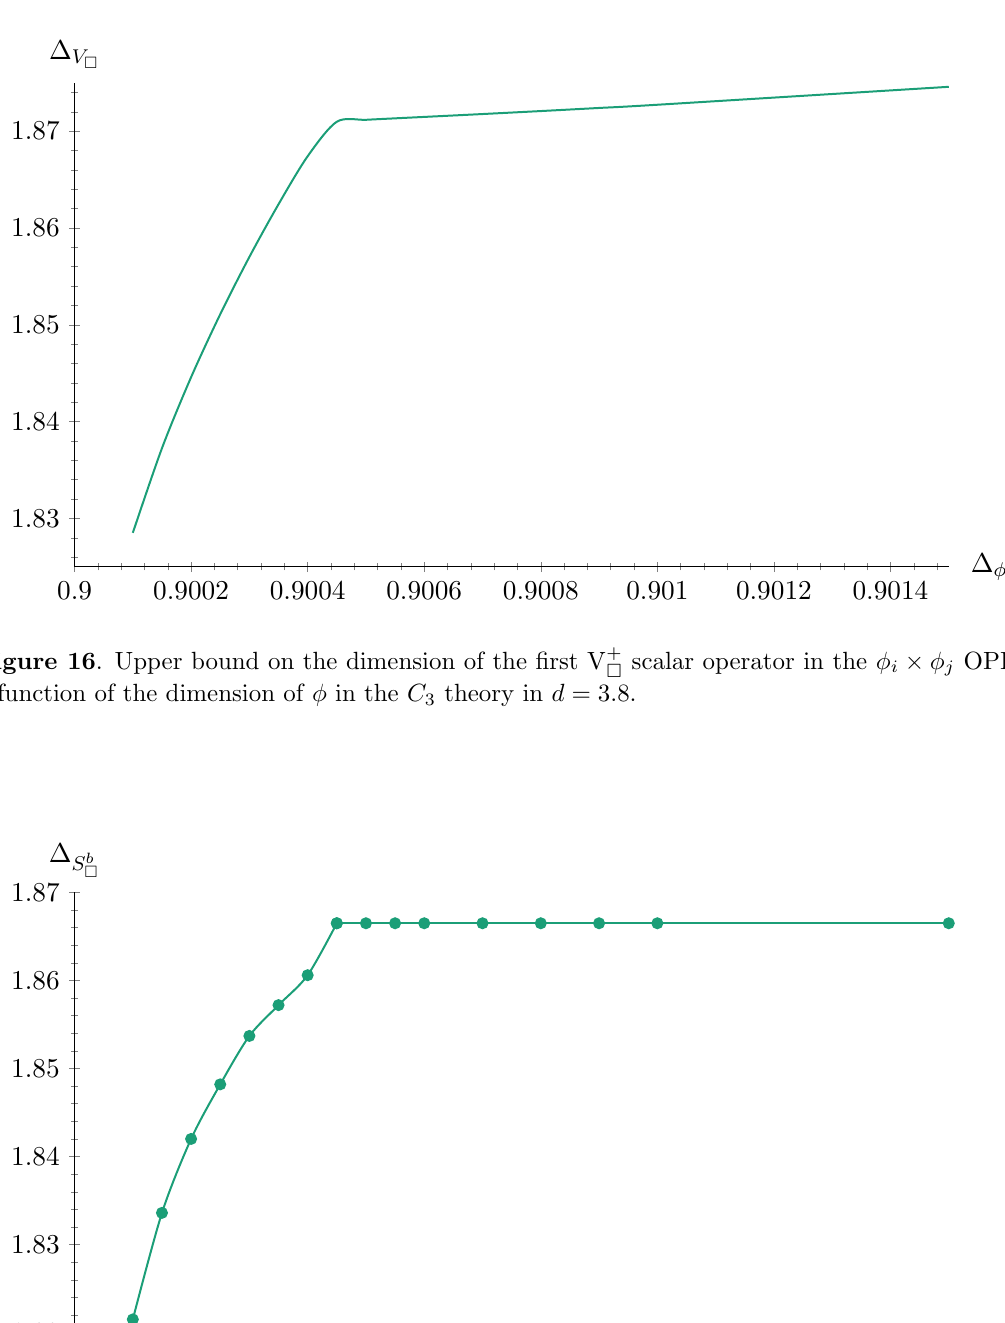
at the C b solution in d = 3 : 8, i.e. assuming that (cid:1) V 3 (cid:3)